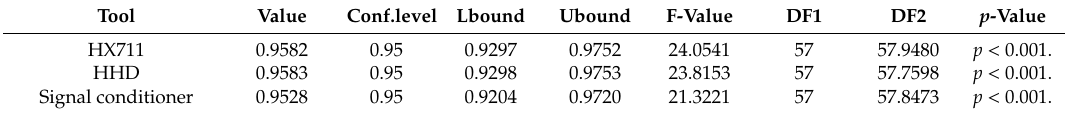
Table 4. Results of ICC calculation comparing each instrument’s from the first session with those from the second session, and their 95% confident intervals, using a mean-rating, absolute-agreement, 2-way mixed-e ff ects model.